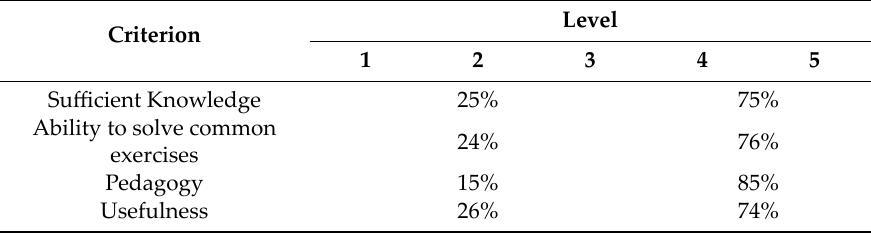
Table 7. Results of the